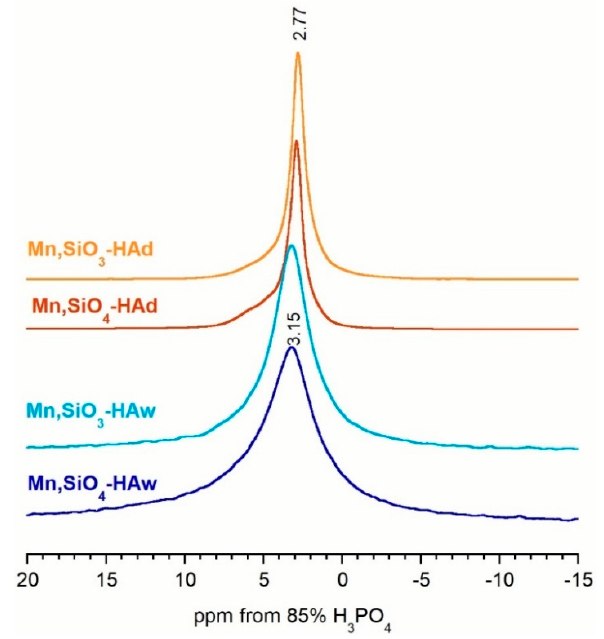
Figure 4. 31 P BD NMR spectra of the analyzed